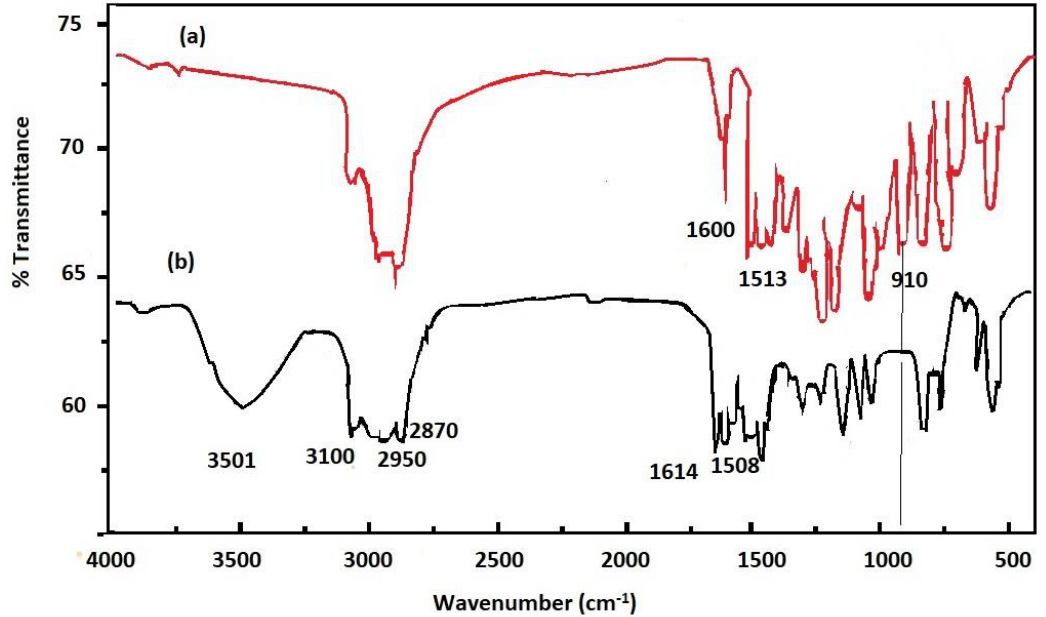
Figure 7. FTIR spectra of ( a ) DGEB and ( b ) DGEB/PAIIL weight ratio (1:1).